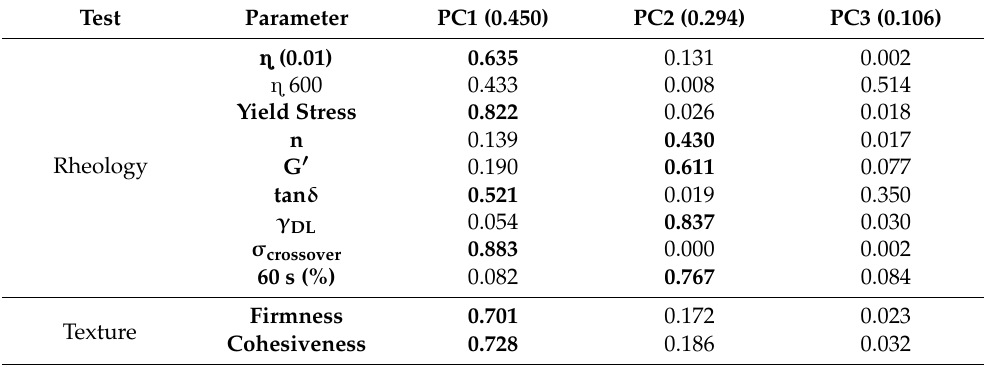
Table 14. Values of cos 2 for each parameter for the three axes of MFA after the sort (the significant values are in bold). The pertinent parameters for PC1 and/or PC2 are in